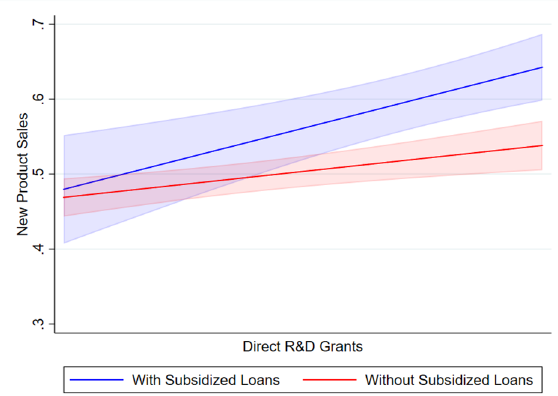
Figure 2. The effects of R&D subsidies on new product